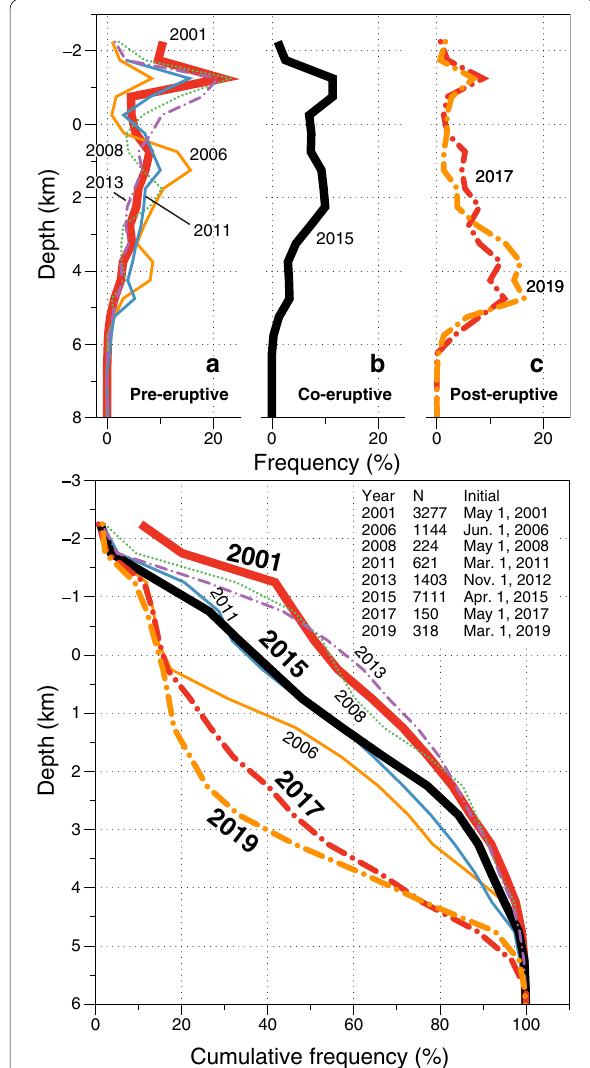
Fig. 11 Frequency–depth variations of volcano-tectonic earthquakes in the hydrothermal system during post-2001 volcanic unrest episodes. Frequencies of every 500 m depth interval are shown. Upper panels; frequency–depth variations of a) pre- b) co- and c) post-eruptive volcanic unrests. Lower panel d) shows cumulative frequency–depth variations for each volcanic unrest episode. We count the number of earthquakes with epicenters within 2 km